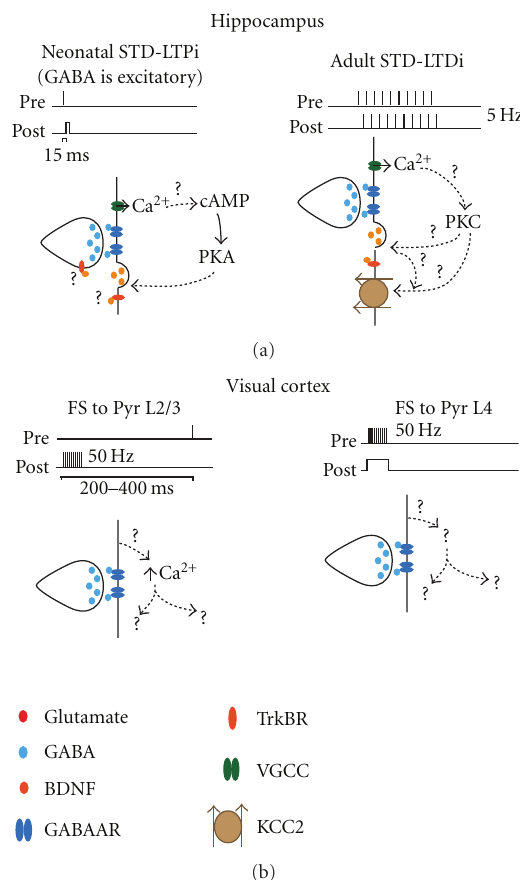
Figure 2: Induction paradigms and mechanisms for monosynaptic inhibitory plasticity. (a) Hippocampus. (b) Visual Cortex.